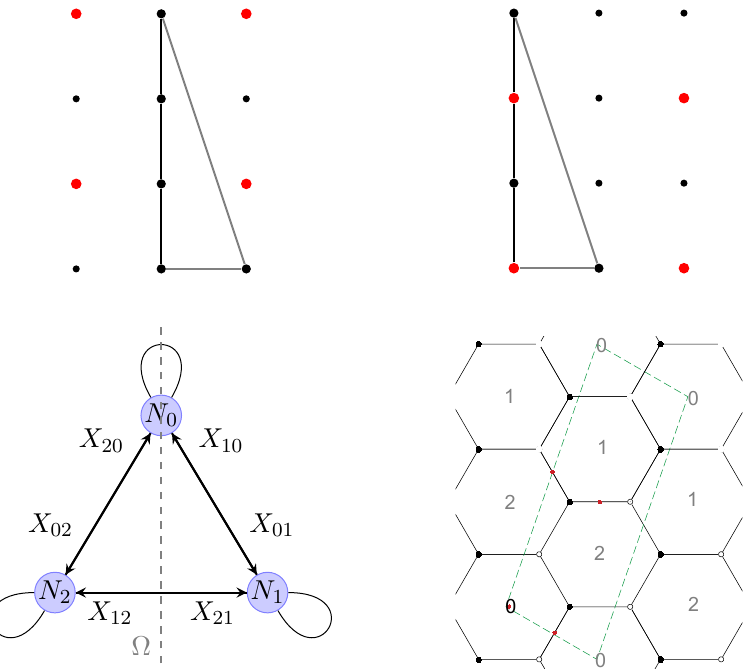
Figure 29. The various unoriented descriptions of C 3 = Z 0 3 . The upper (cid:12)gure shows the toric diagram and the toric involution with a compact (cid:10)3 (left) and a non-compact (cid:10)7 (right). In the lower row: the left side show the quiver and the (cid:10)-line, whereas on the right side the dimer and the four (cid:12)xed points in red.